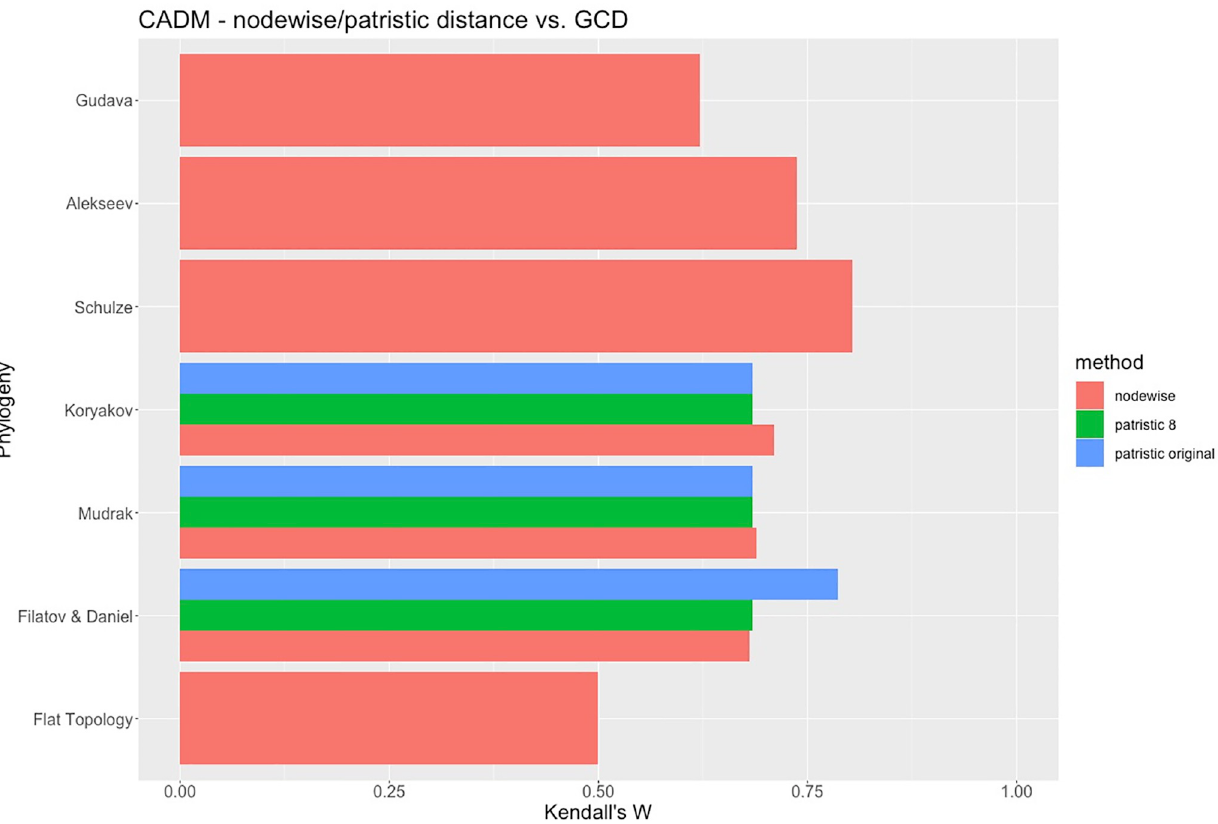
Fig 6. Kendall’s W for the congruence of each phylogeny with geography. Red bars consider nodewise normalized phylogenies, for 8 villages. Green bars consider patristic distances for quantitative phylogenies, restricted to 8 villages. Blue bars consider patristic distances for quantitative phylogenies, using the original data in each case (6 villages for Koryakov, 9 for Mudrak, and 20 for Filatov & Daniel).